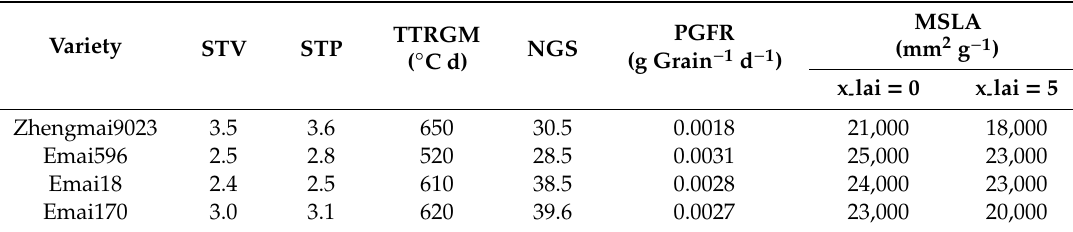
Table 4. Genetic parameters, sensitivity to vernalization (STV), sensitivity to photoperiod (STP), thermal time required from grain-filling to maturity (TTRGM), numbers of grain per stem (NGS), potential grain filling rate (PGFR), and maximum specific leaf area for ∆ LAI (MSLA) for the model simulation of the four wheat varieties in Hubei province.